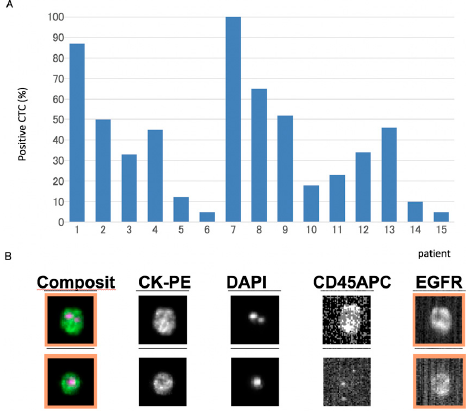
Figure 1. ( A ) Quantitation of epidermal growth factor receptor (EGFR) expression in CTCs by automated immunofluorescence assay. The percentage of EGFR-positive CTCs relative to total CTCs was analyzed in samples with >5 CTCs and ( B ) A patient sample shows an individual CTC stained positive for EGFR expression.